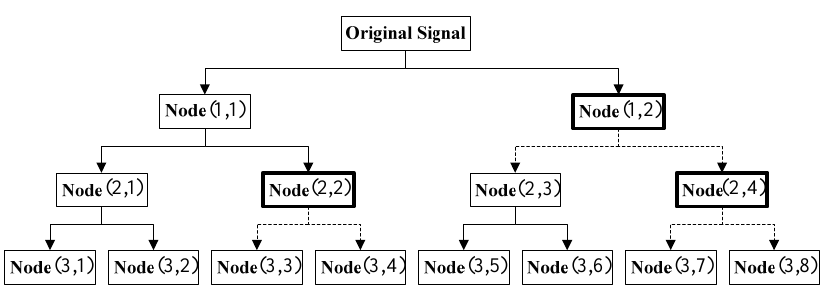
Figure 4. Schematic solution to band